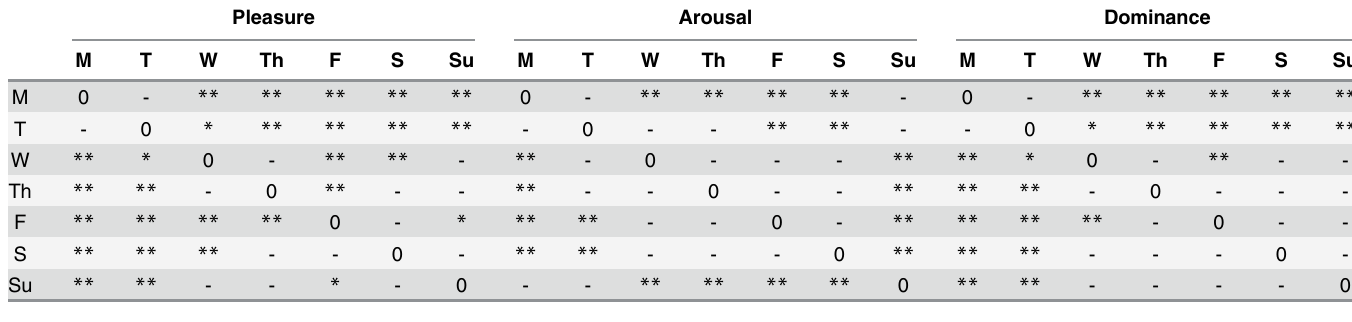
Table 3. Pairwise comparisons (Tukey ’ s HSD) between weekdays for the Pleasure (left), Arousal (centre), and Dominance (right) ratings in Study